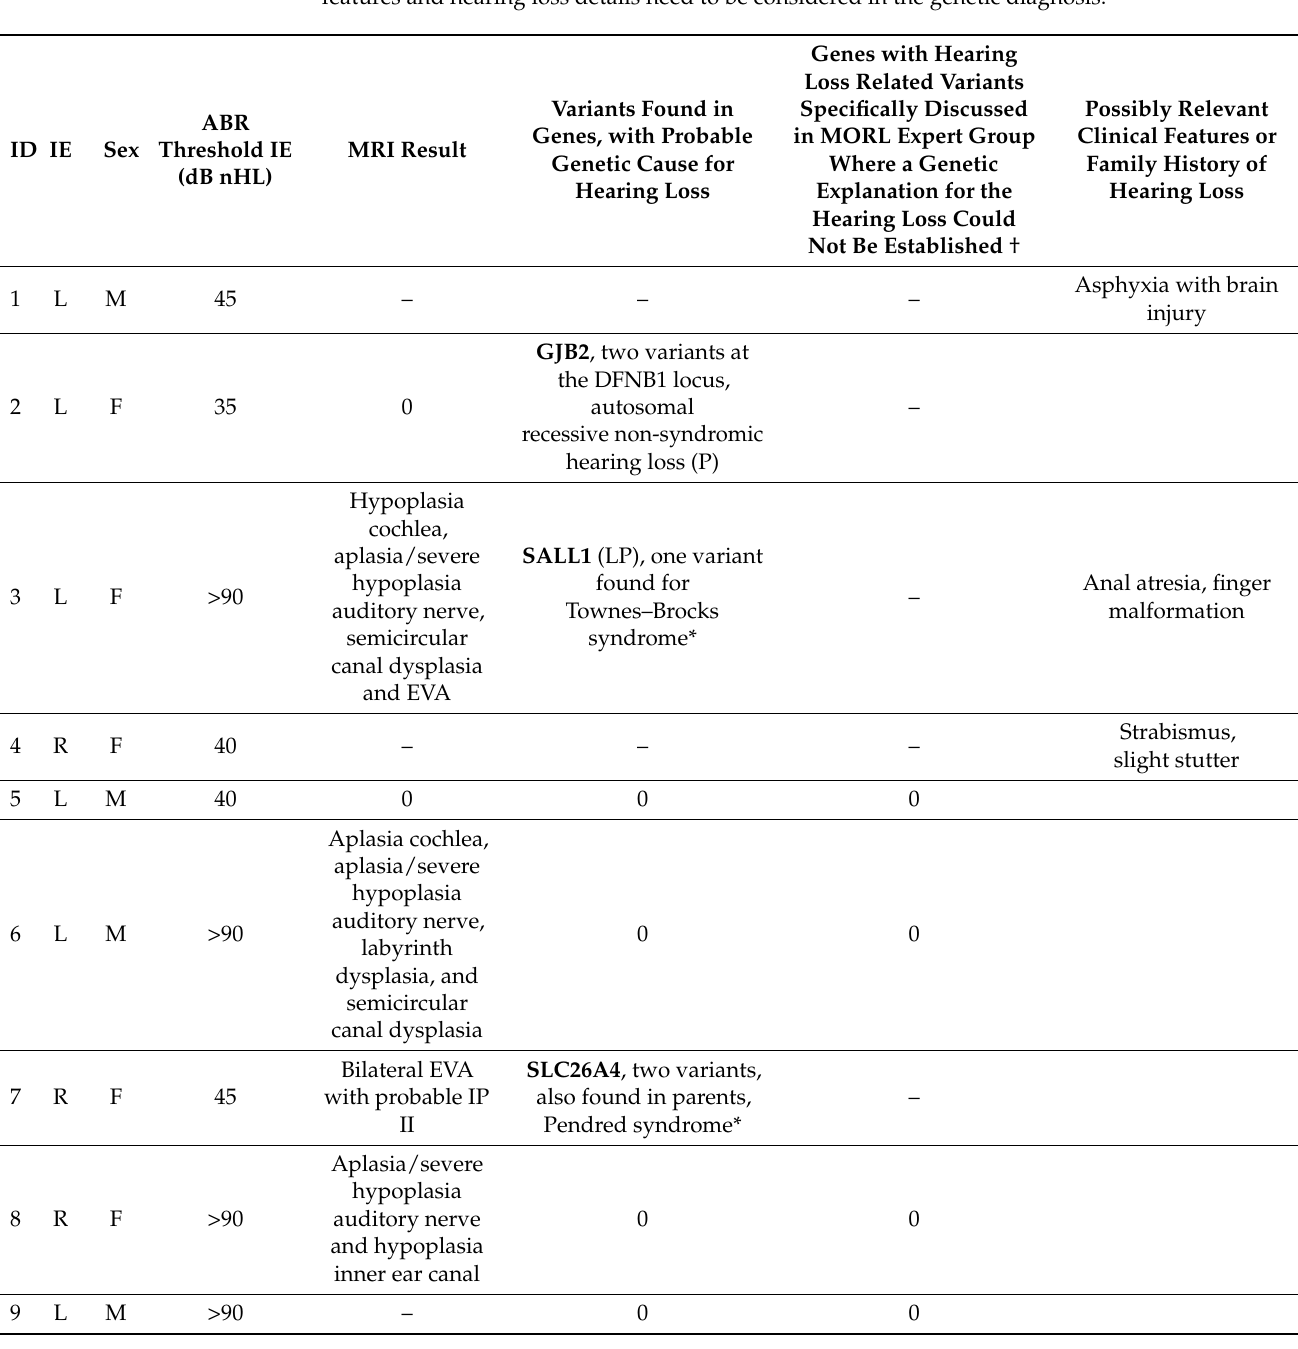
Table 1. Genetic findings (bold) together with previously published magnetic resonance imaging (MRI) and auditory brainstem response thresholds (ABRthrs) [20]. All subjects had ≤ 20 dB nHL ABR Thresholds (ABRthrs) in their normal-hearing ear at diagnosis (median age 2.2 months). Vari- ant interpretation reflects Molecular Otolaryngology and Renal Research Laboratories (MORL) expert opinion and considers all extracted data from the Deafness Variation Database (DVD, http://deafnessvariationdatabase.org/ (accessed on 15 December 2022)). Genetic variants discussed in MORL expert group where an explanation for the uSNHL could not be established are also in- cluded in the table, as many genetic variants may be found with genetic testing. Therefore, clinical features and hearing loss details need to be considered in the genetic